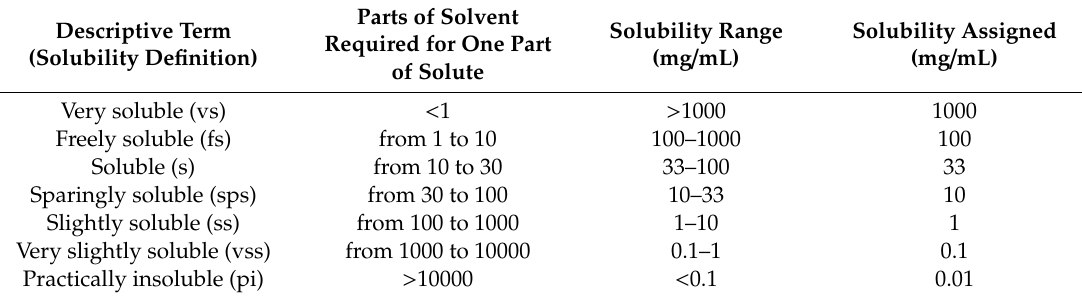
Table 1. Solubility definitions [36,39,40].